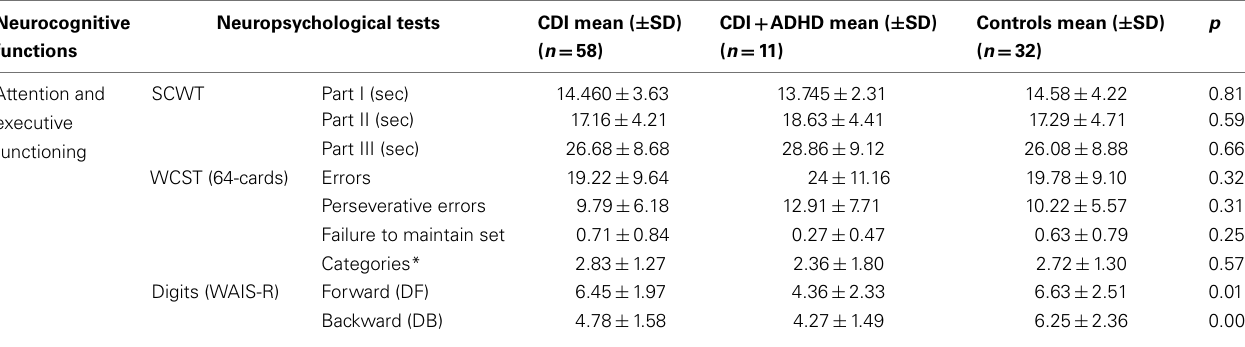
Table 3 | Performance of CDI, CDI + ADHD, and healthy controls in traditional neuropsychological tests designed to evaluate executive cognitive functioning (ECF).